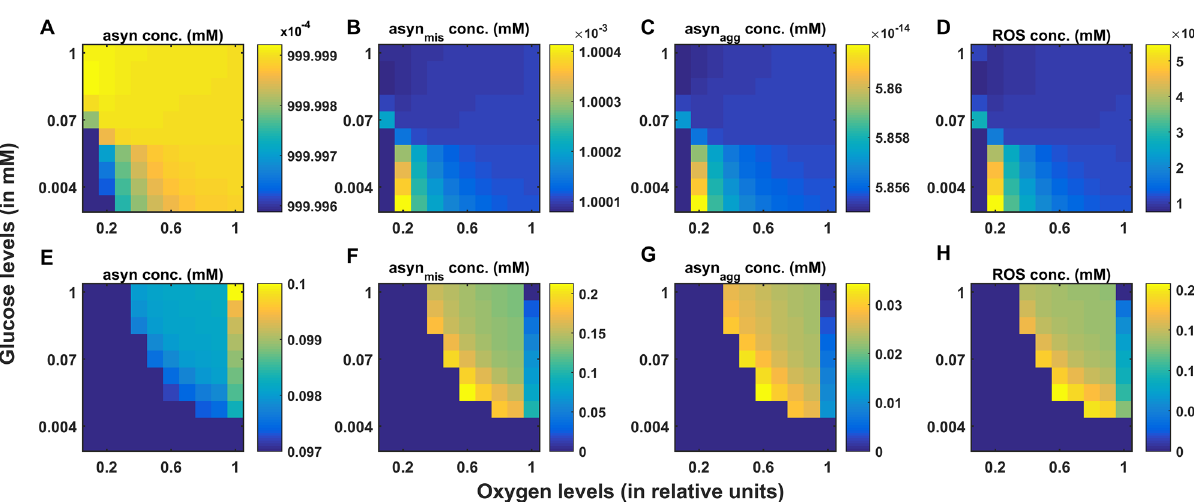
Figure 7. Responses of whole ( A–D ) and reduced ( E–H ) models to hypoglycemia and hypoxia conditions. Average normal alpha-synuclein (asyn) concentration ( A , E ), average misfolded alpha-synuclein (asyn mis ) concentration ( B , F ), average aggregated alpha-synuclein (asyn agg ) concentration ( C , G ), and average reactive oxygen species (ROS) concentration ( D , H ) of the fast and slow dynamic models for varying glucose and oxygen concentrations. conc concentration, mM